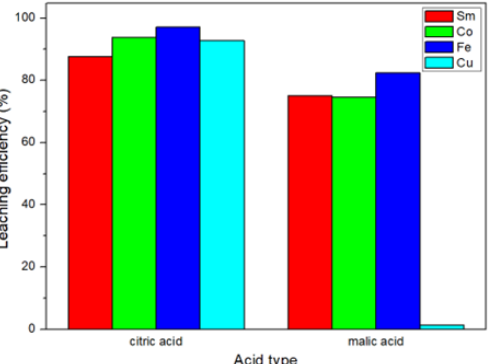
Figure 4. Comparison of leaching efficiencies of organic acids.